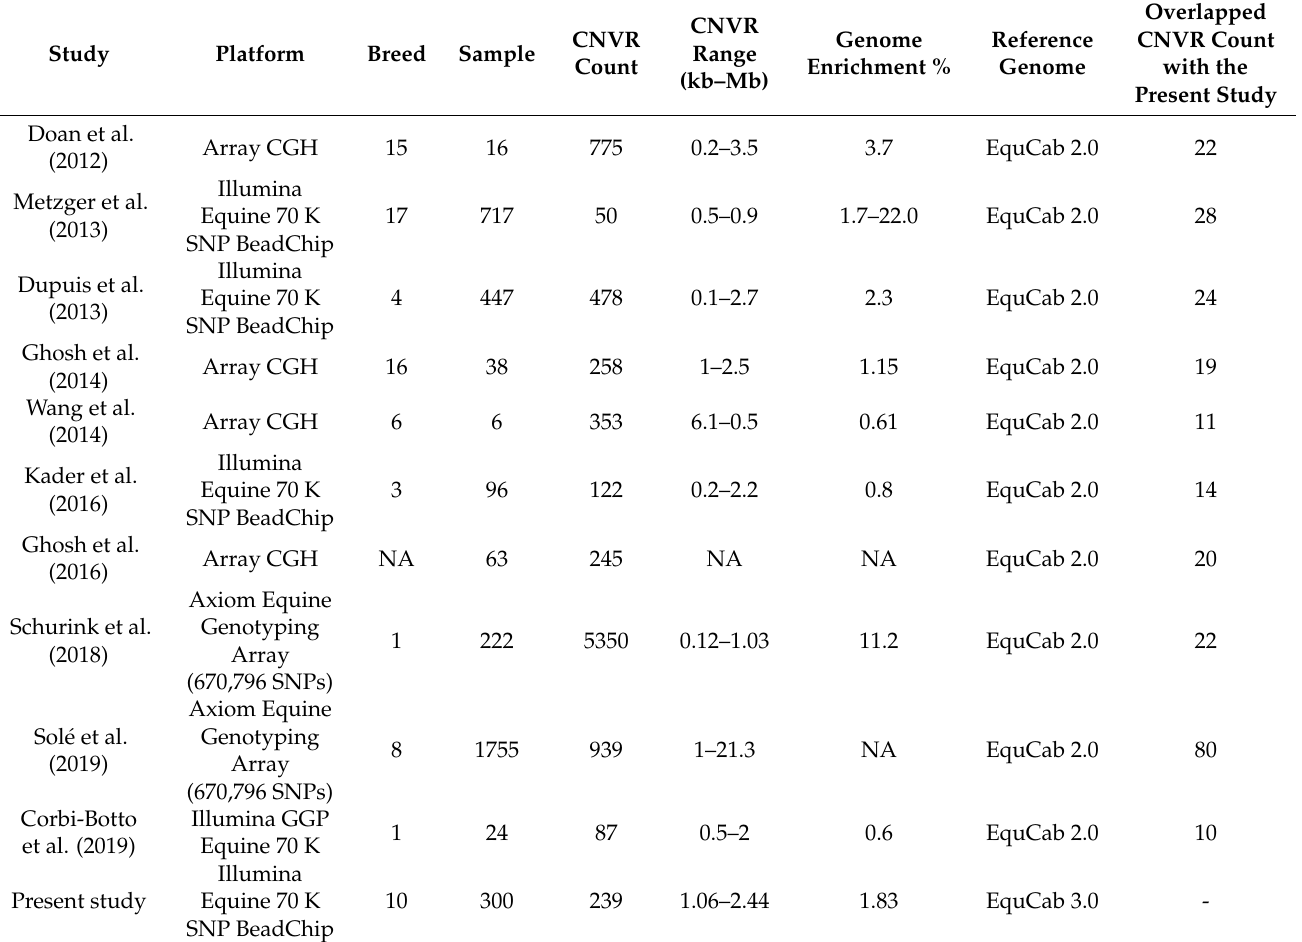
Table 5. Comparison of CNVRs identified in this study with those identified in ten previous